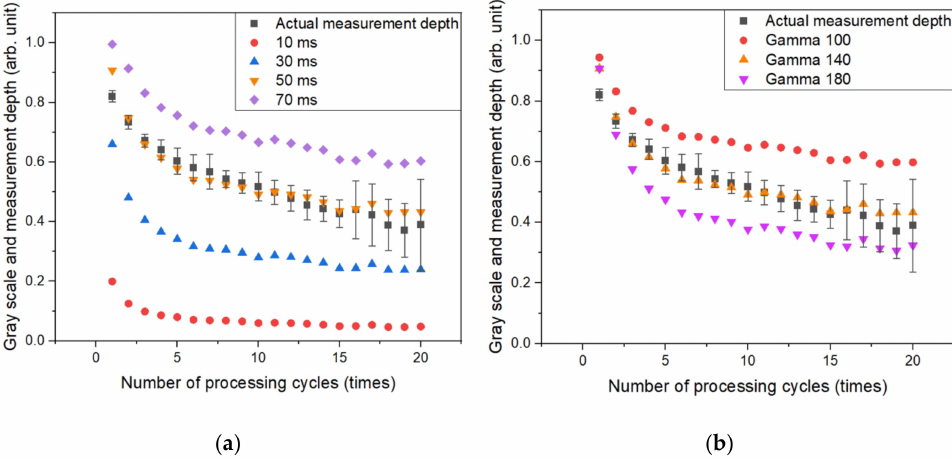
Figure 7. ( a ) Correlation between the real hole depth and gray scale according to optical microscope exposure duration. ( b ) Correlation between the real hole depth and gray scale based on the optical microscope gamma